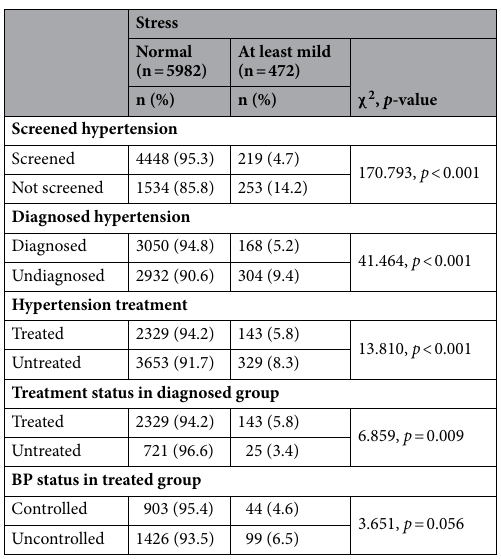
Table 7. Stress status across hypertension care continuum. BP, blood pressure. Values in parentheses are the percentage of the cases.